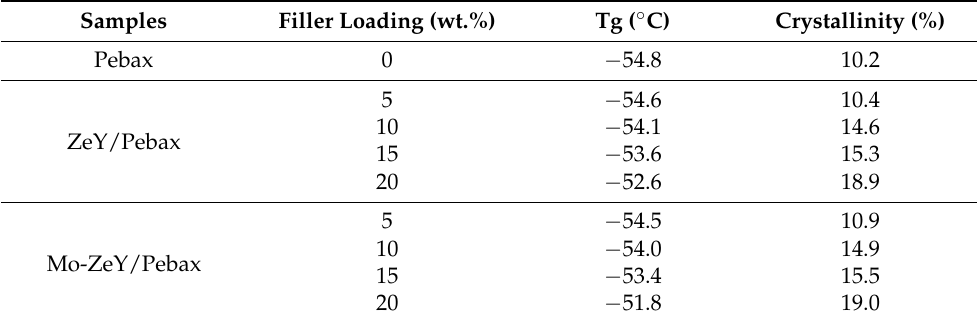
with different ZeY and Mo-ZeY